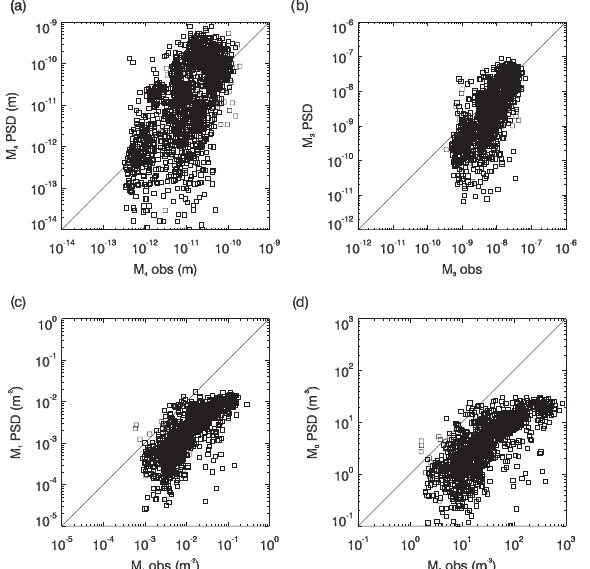
Figure 9. Moments (fourth, third, first and zeroth) of the observed particle size distribution by the aircraft (for particles with diameters > 100µm) and predicted using the PSD parameterisation with the observed ice water content ( > 10 − 3 gm − 3 ) , temperature and mass– diameter relationship.